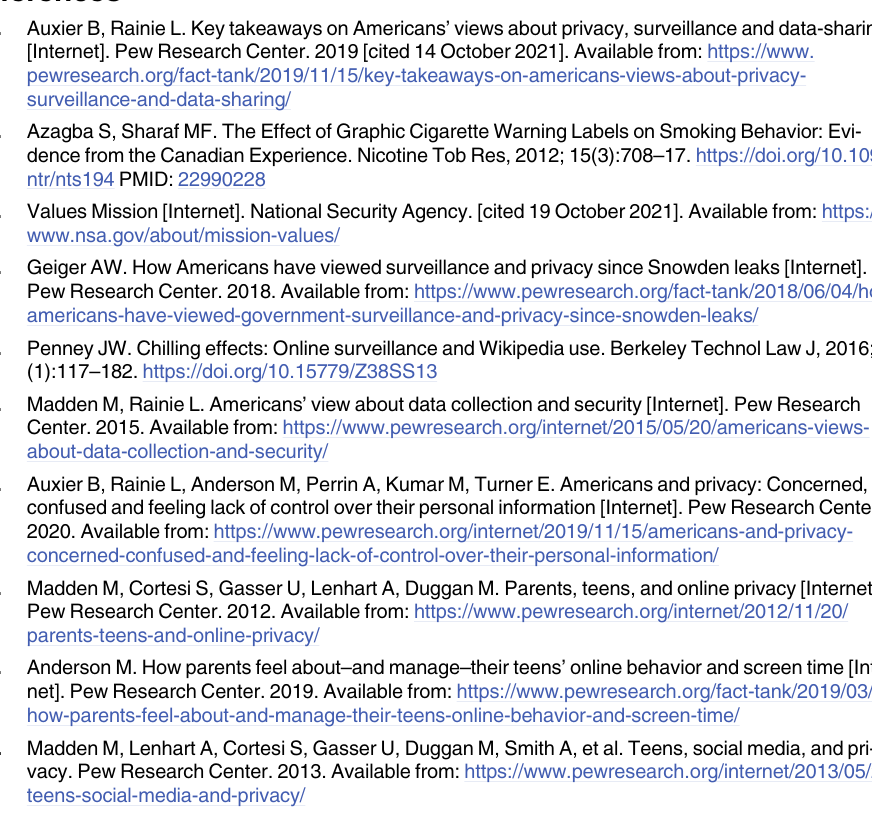
S5 Fig. Group 5 screen (partial